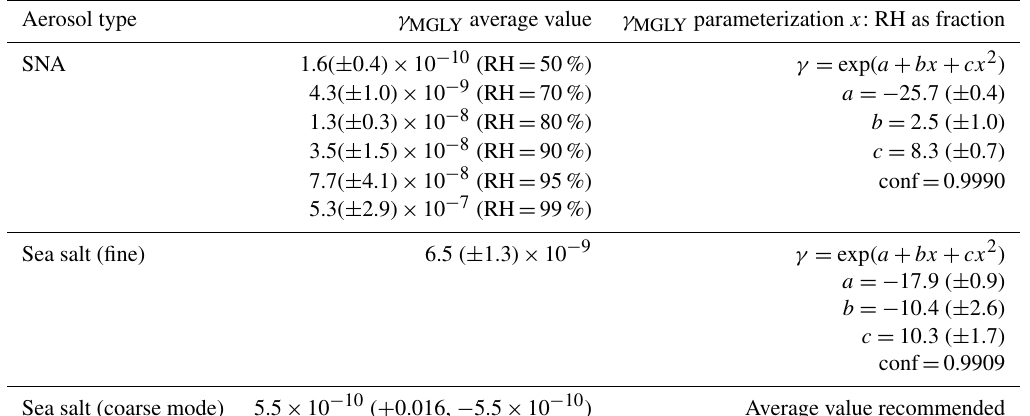
Table 5. Summary of γ MGLY recommendations for